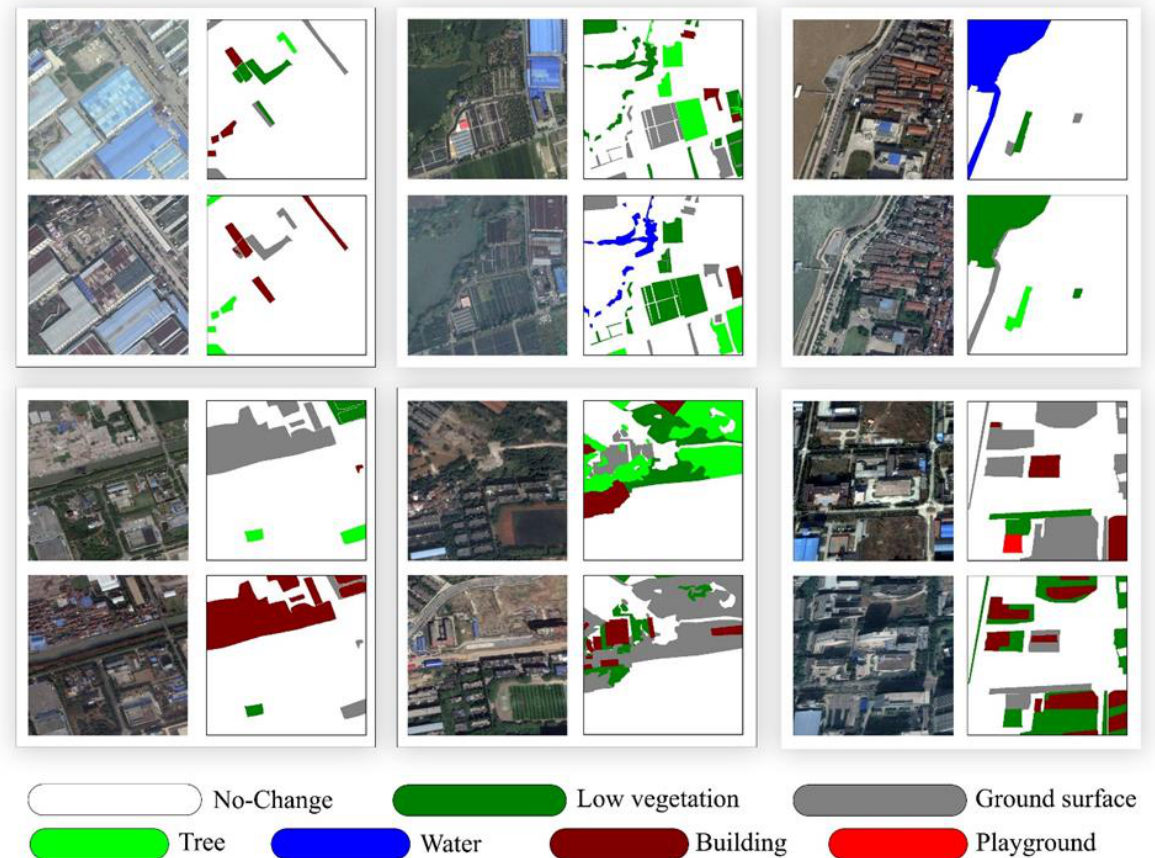
Figure 1. Multiple samples from the SECOND benchmark dataset. The white region is associated with no-change and other colors depict different land-cover